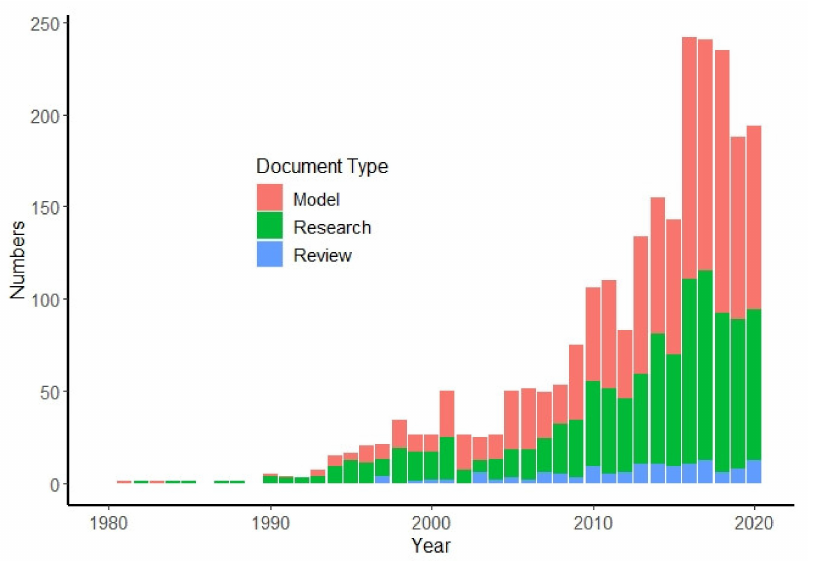
Figure 2. Peer-reviewed publications on N 2 O and agriculture since 1990 searched in the SCO- PUS database.